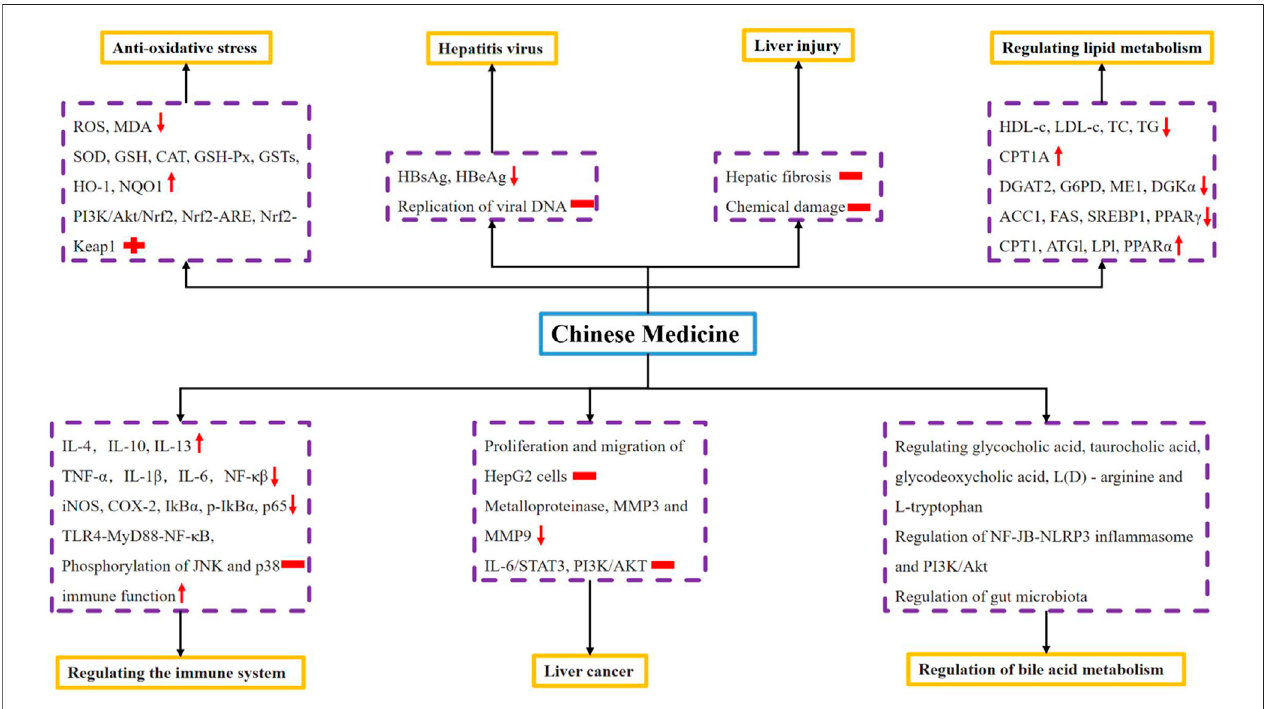
FIGURE 3 | Pharmacological effects of Chinese medicine on liver